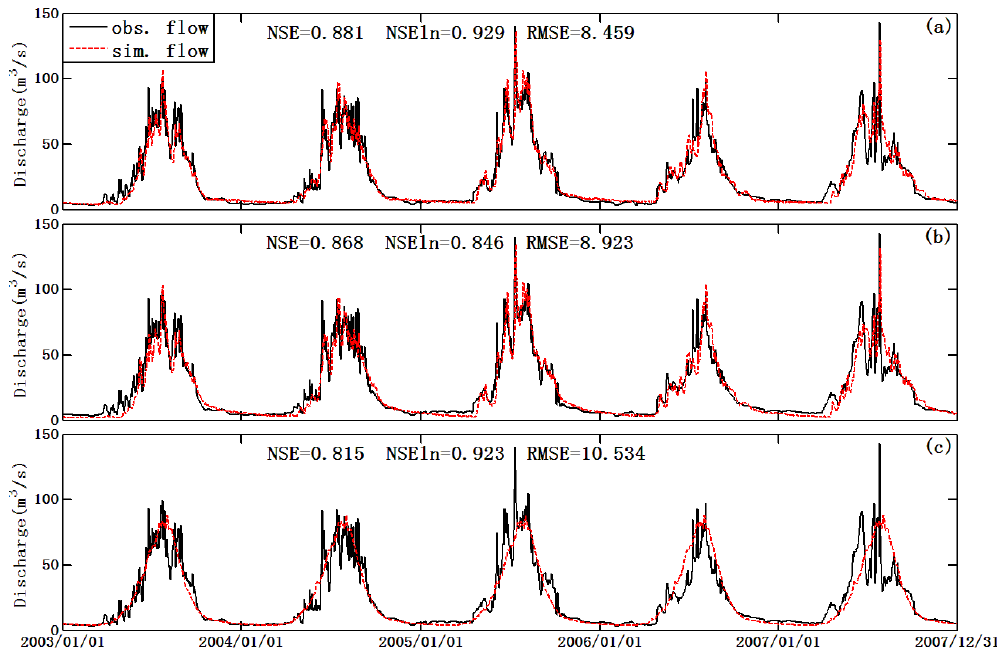
Figure 8. Simulation of daily streamflow by different methods from 2003 to 2007. (a) by the proposed stepwise method, (b) by the automatic calibration method, and (c) by the benchmark model. The performance of the simulations is measured in NSE, NSEln, and